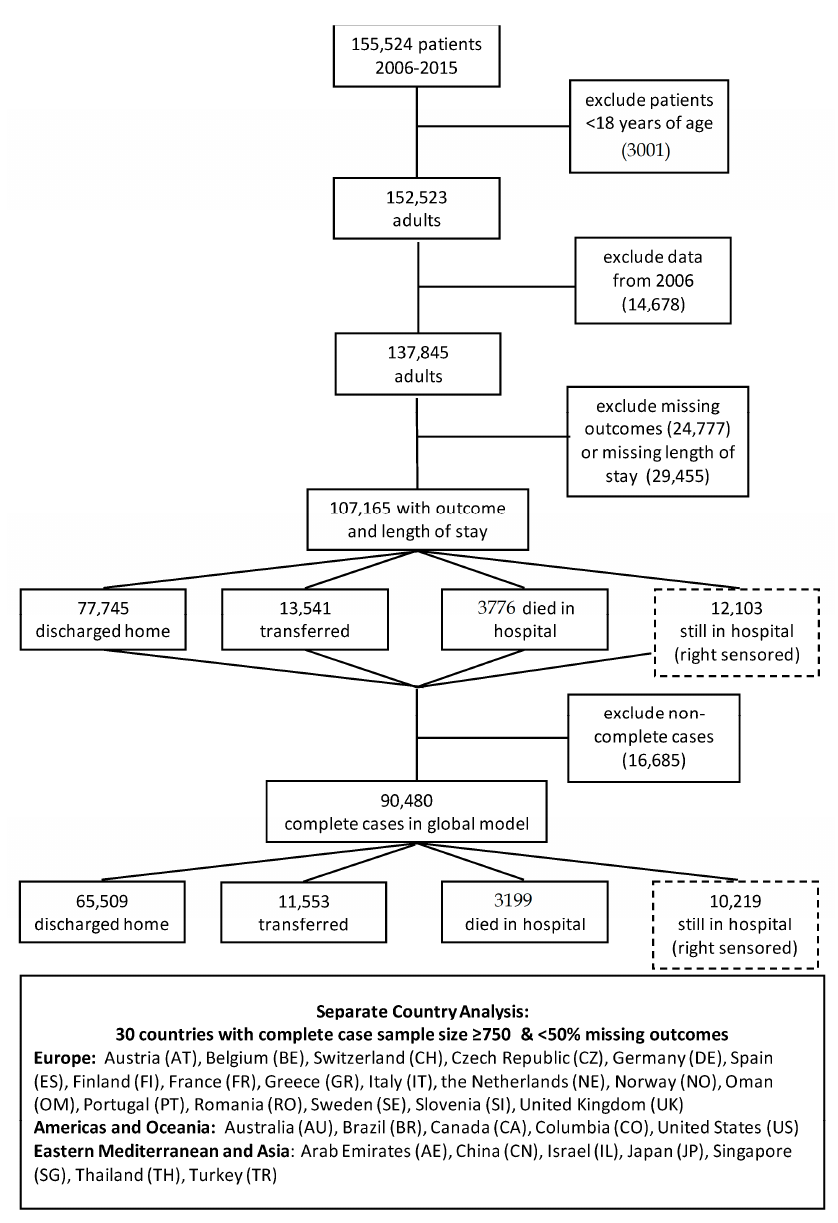
Figure 1. Participant